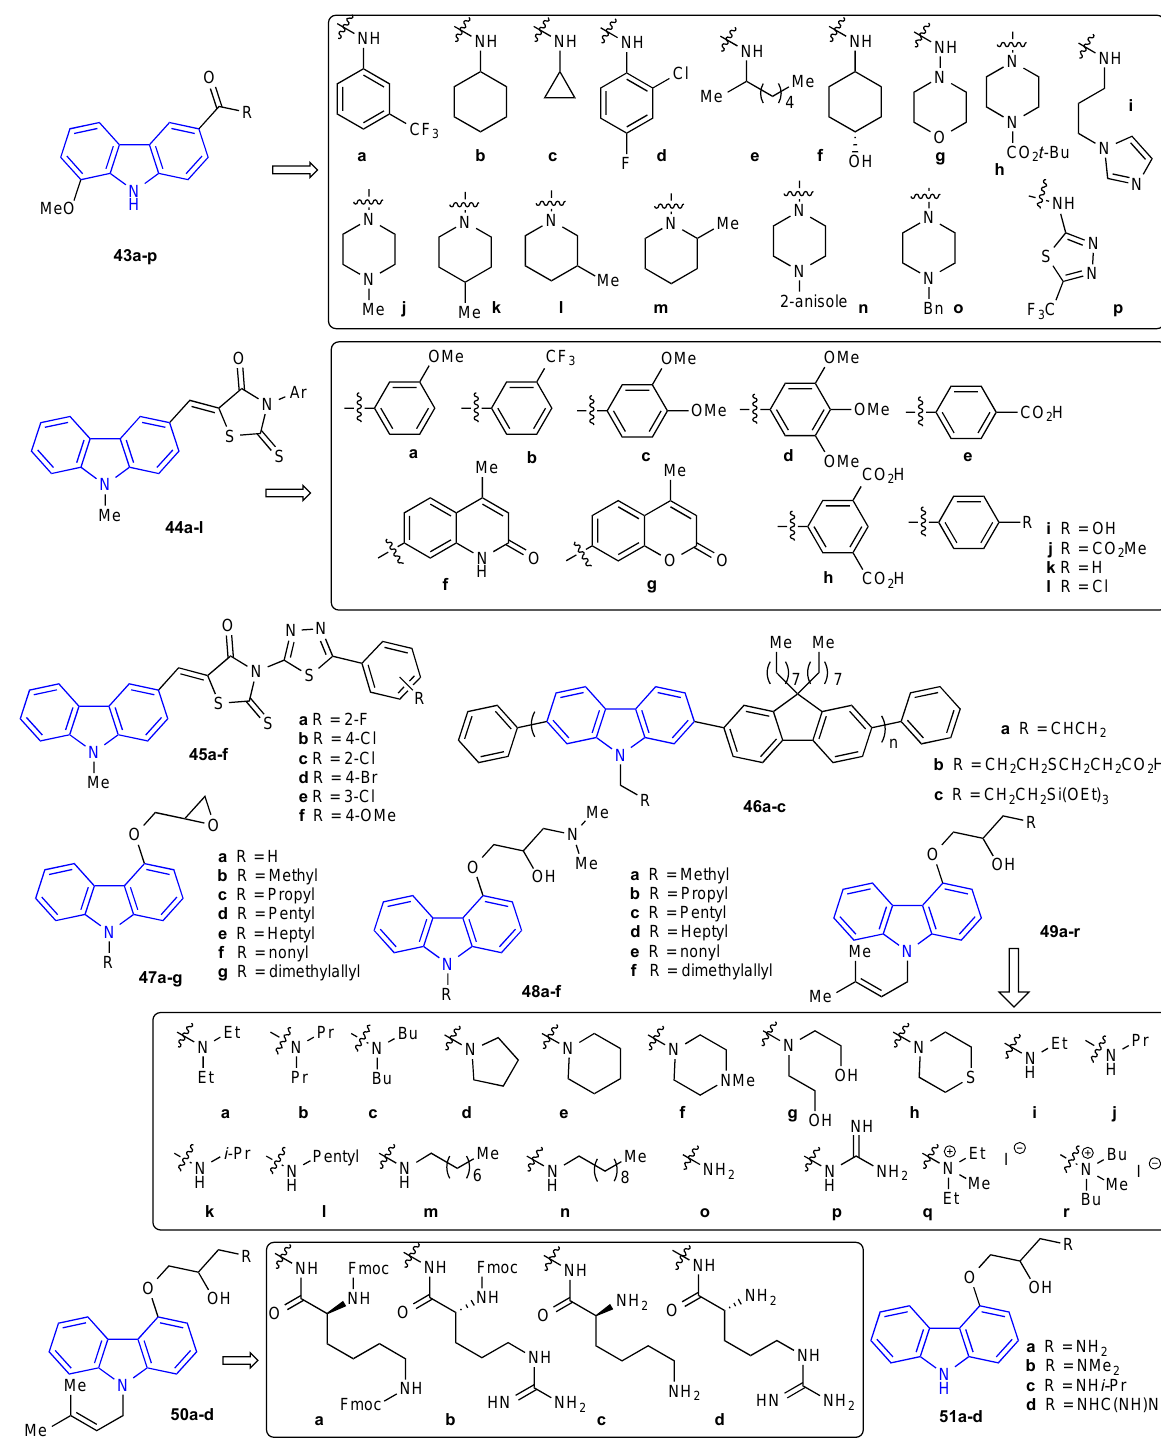
Figure 7. Structures of the reported carbazole derivatives from 2019 to 2020 . In 2020, Bordei and coworkers reported the synthesis and antimicrobial activity of seven carbazole derivatives bearing either acylhydrazides ( 52a-c ) or oxadiazoles ( 53a-d ), as depicted in Figure 8. These seven adducts were screened against a panel of Gram-pos- itive strains ( S. aureus (ATCC 25923) and E. faecalis (ATCC 292121)) , Gram-negative strains ( E. coli (ATCC 25922) and P. aeruginosa (ATCC 27853)) and one fungus ( C. albicans (ATCC 90029)). The MIC values were obtained using the microdilution method in liquid Mueller Hinton medium. All microorganisms showed susceptibility to the tested compounds,